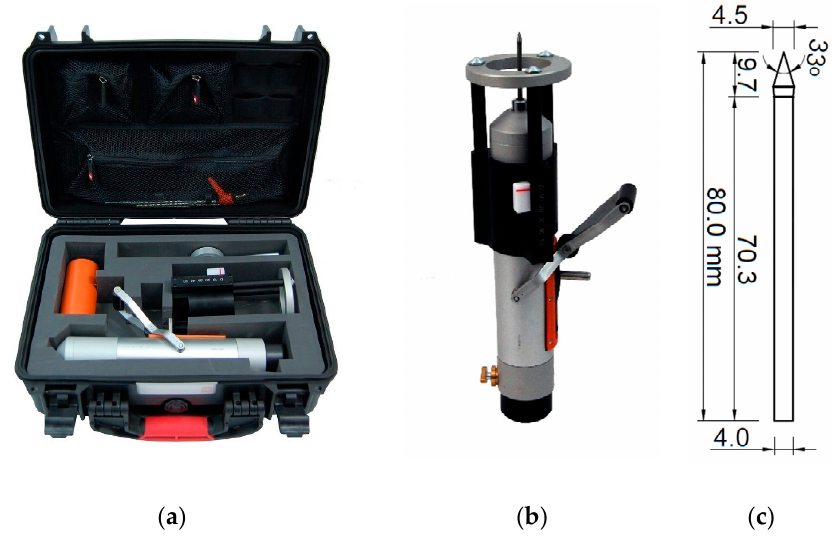
Figure 2. Penetrometer RSM-15 [34]: ( a ) complete testing set; ( b ) measurement device; ( c ) steel needle geometry.